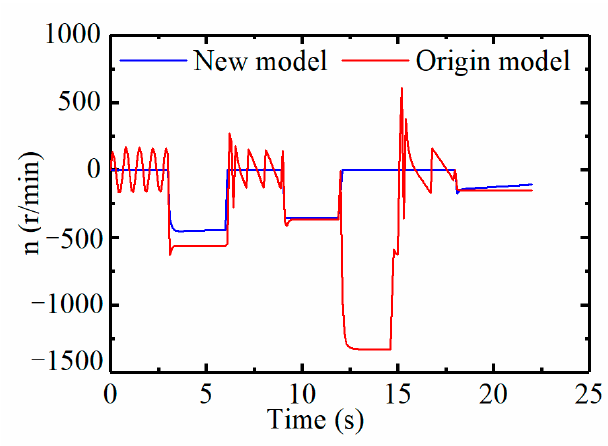
Figure 9. The motor speed comparison chart.